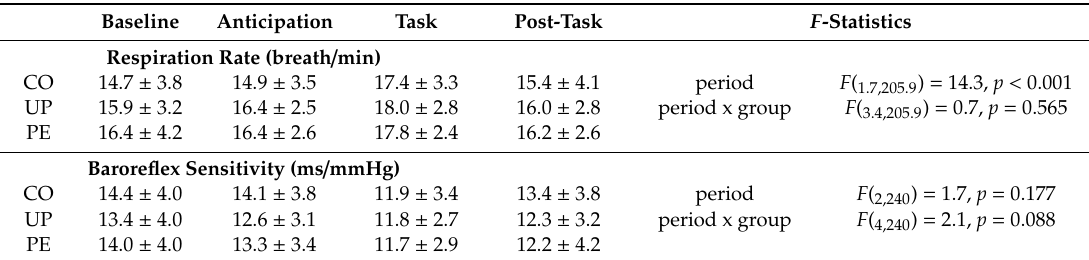
Table 2. Respiration rate and baroreflex sensitivity (mean ± SD) of participants, and statistical results for group di ff erences in response to the stress manipulation. CO: women without gestation during the last three years; UP: women with uncomplicated pregnancies; PE: women with a history of preeclampsia.